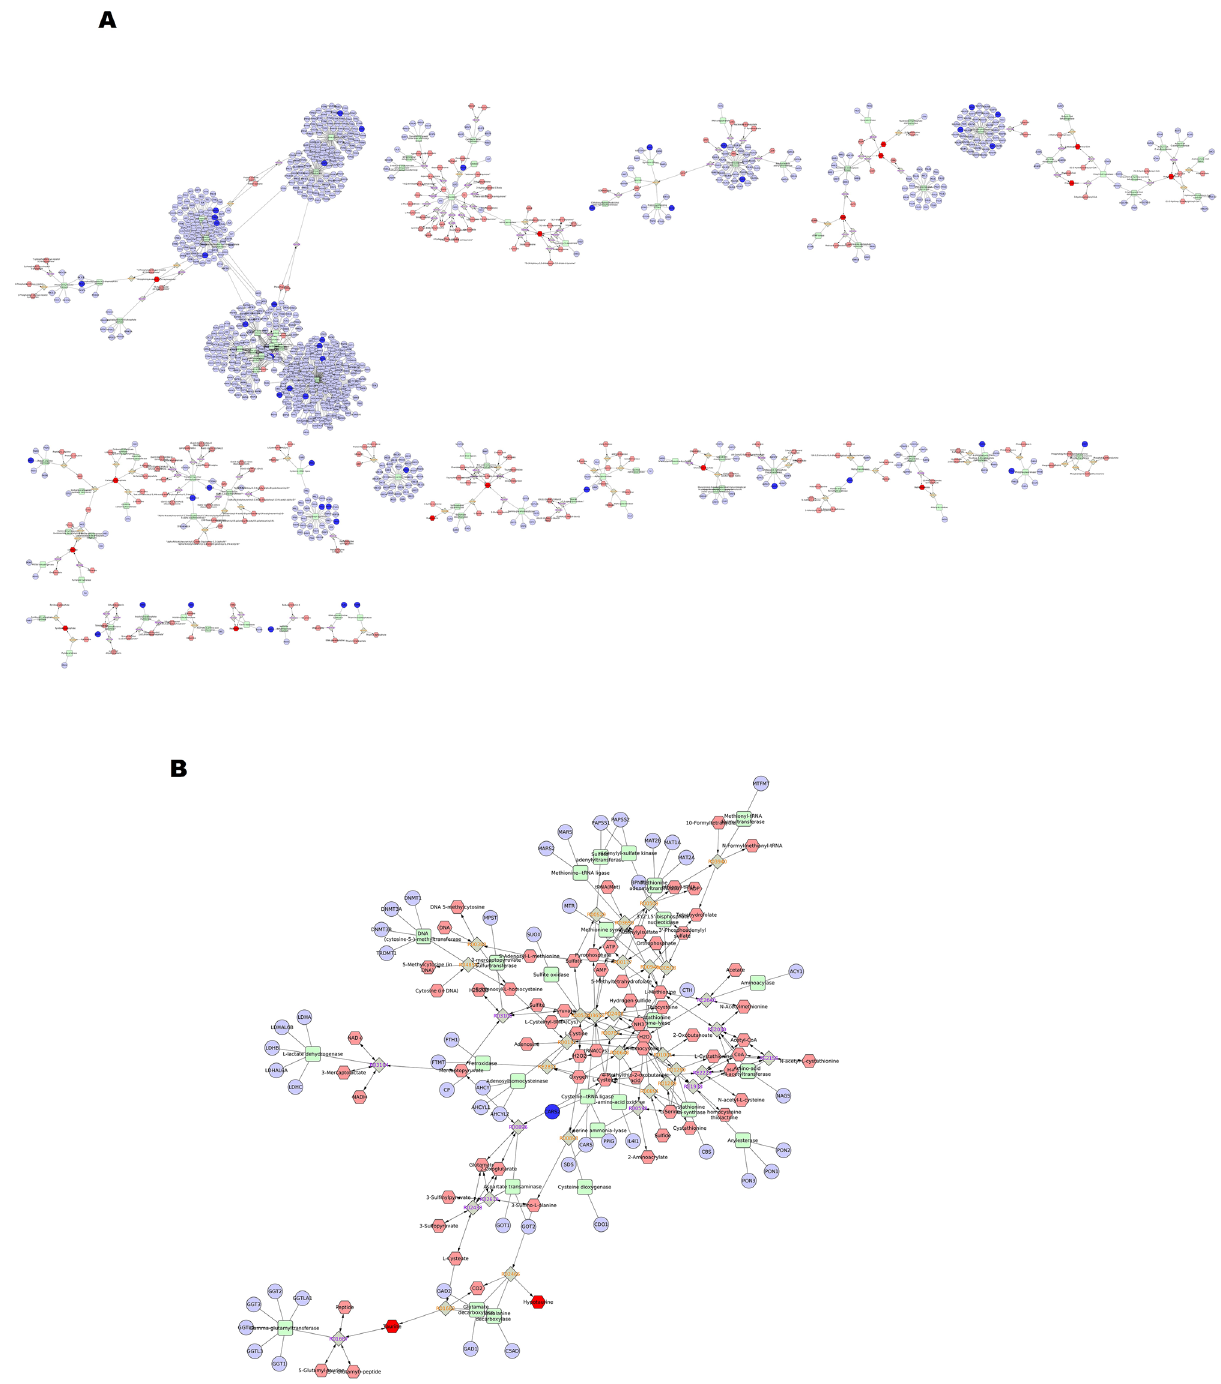
Figure 6. ( A ) Interaction network of dysregulated proteins and metabolites. ( B ) Subnetwork of Methionine and cysteine